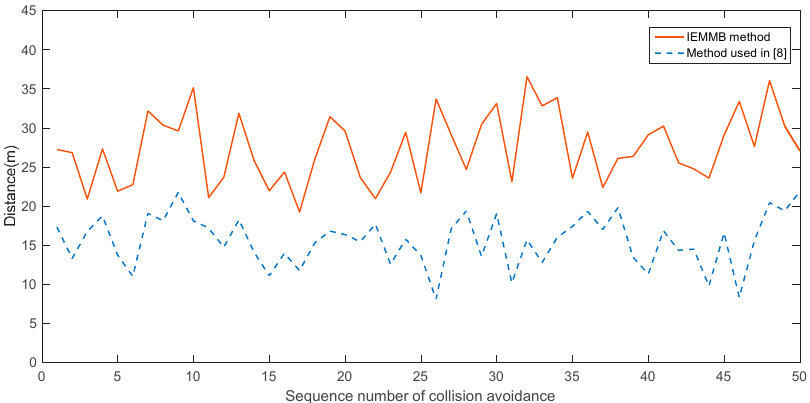
Figure 14. Collision detection distance on winding roads. The detection distance of the IEMMB method on a winding road is longer than the method used in [8].